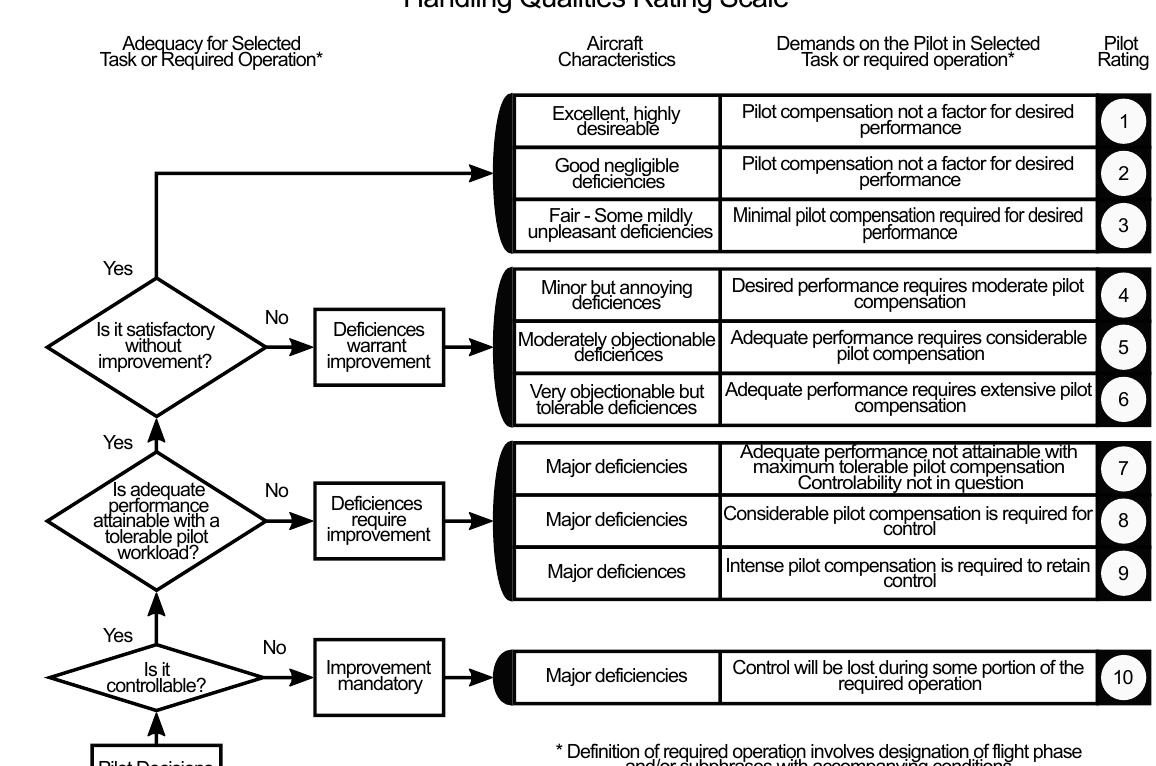
Figure A2. Cooper–Harper Handling Qualities Rating Scale (HQR) with level 1 HQ (HQR-1–HQR-3),